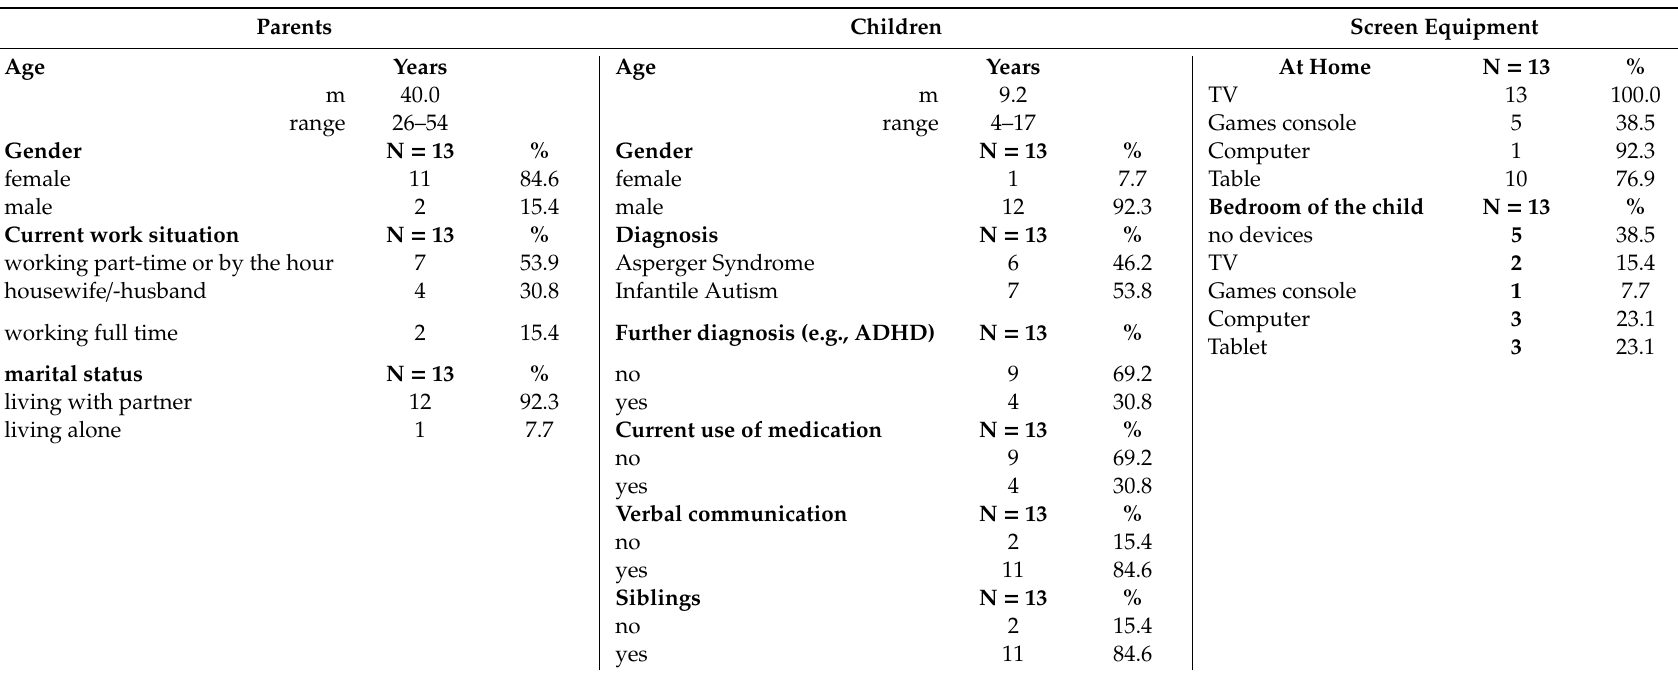
Table 2. Basic characteristic of the participants in the interview study and their child as well as the screen equipment (home, bedroom of the